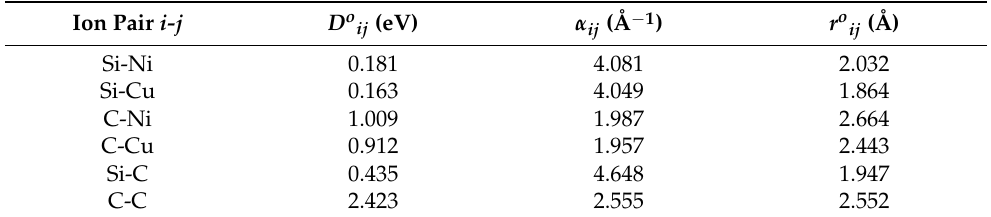
Table 2. Morse potential parameters describing the interaction of deposited particles with metal and graphite